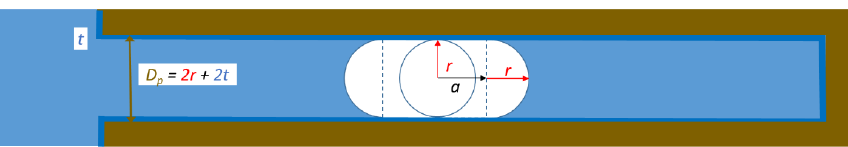
Figure 5. Ice nucleation and growth within a cylindrical pore of diameter D p = 2 r + 2 t , with a describing the growth along the pore axis, t being the thickness of the QLL, and r being the maximum radius the embryo can reach perpendicular to the pore axis.